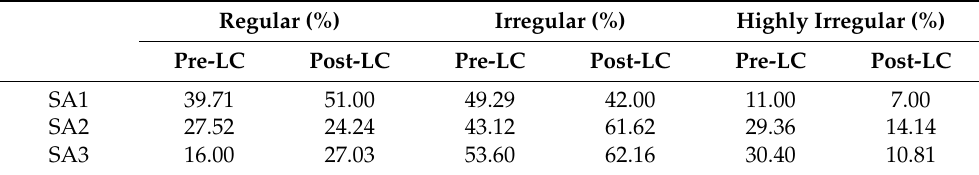
Table 3. Classification of the block according to the pre-LC and post-LC geometric regularity.